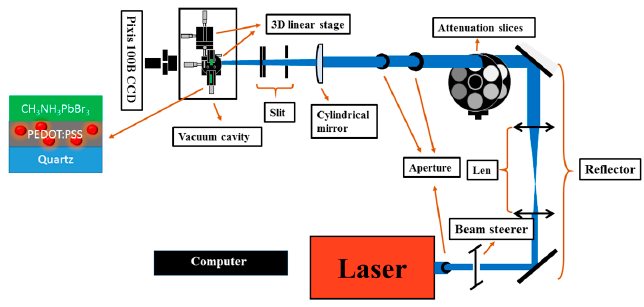
Scheme 1. The ASE test experimental optical path and the device